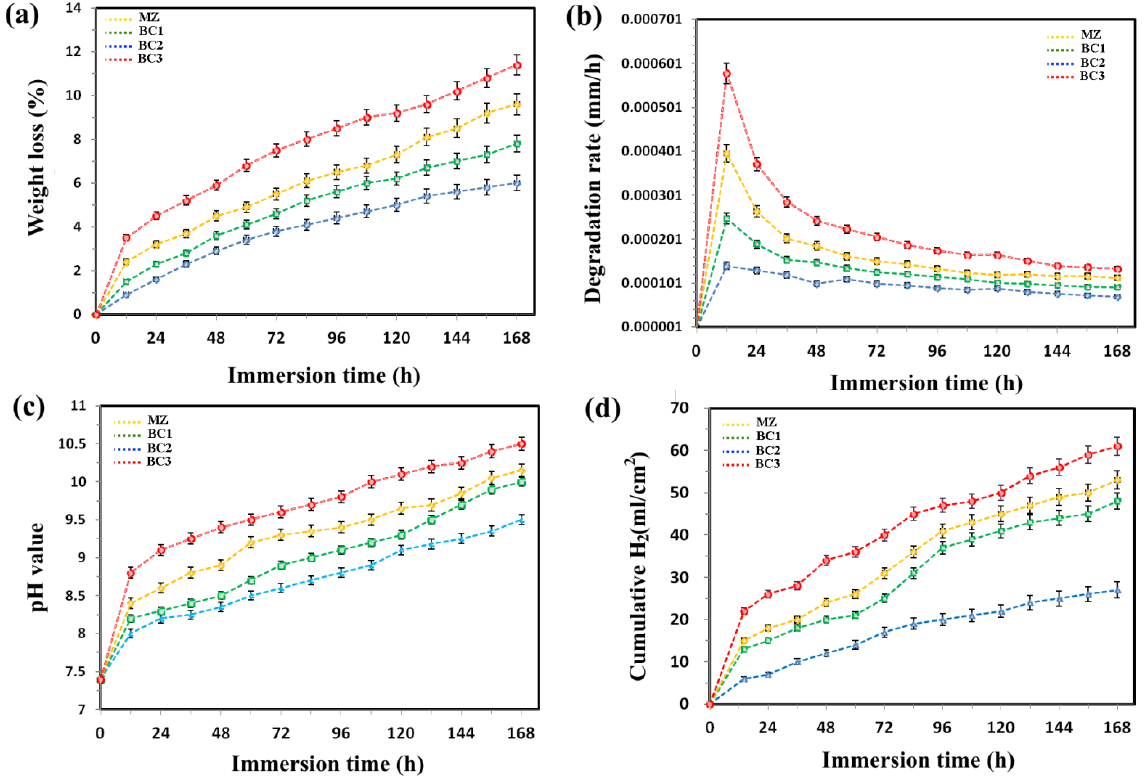
Figure 9. Graphs of ( a ) weight loss, ( b ) degradation rate, ( c ) pH values and ( d ) H 2 values associated with various composites subjected to immersion